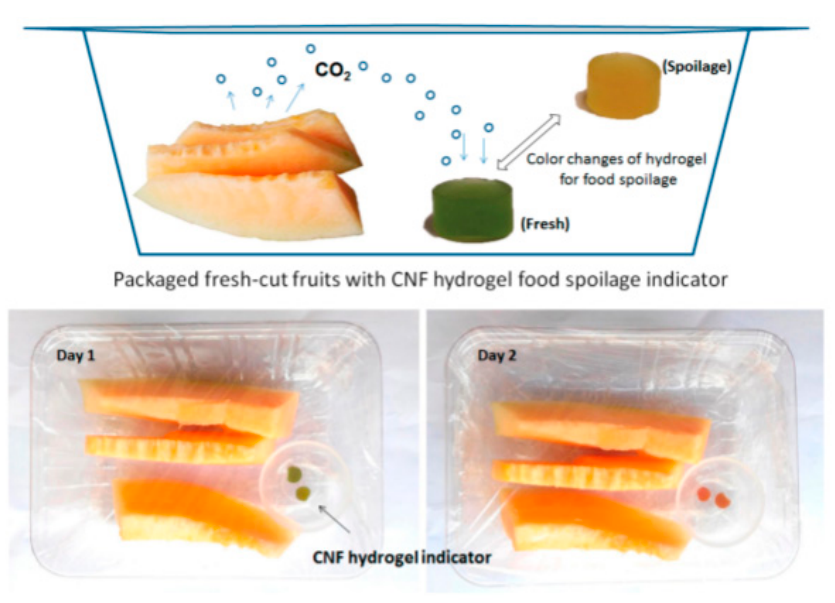
Figure 8. Color changes detected by the cellulose nanofibrils hydrogel indicator. The figure above was adapted with permission from the cited reference [131].